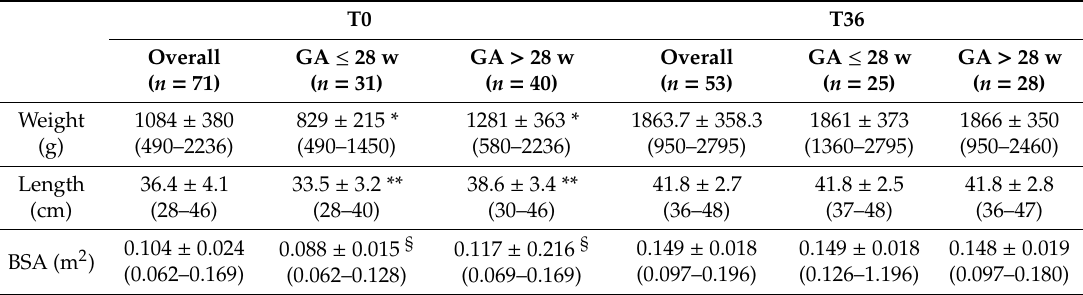
Table 3. Anthropometric data in the overall population and in subjects with a GA ≤ or > 28 weeks, at T0 (3rd day of life) and T36 (gestational age 36 weeks). Data are expressed as mean ± SD (ranges).